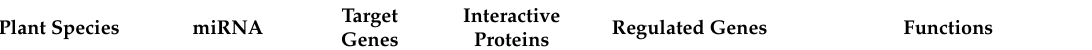
Table 1. The functionally characterized miR393 and TIR1/AFBs in